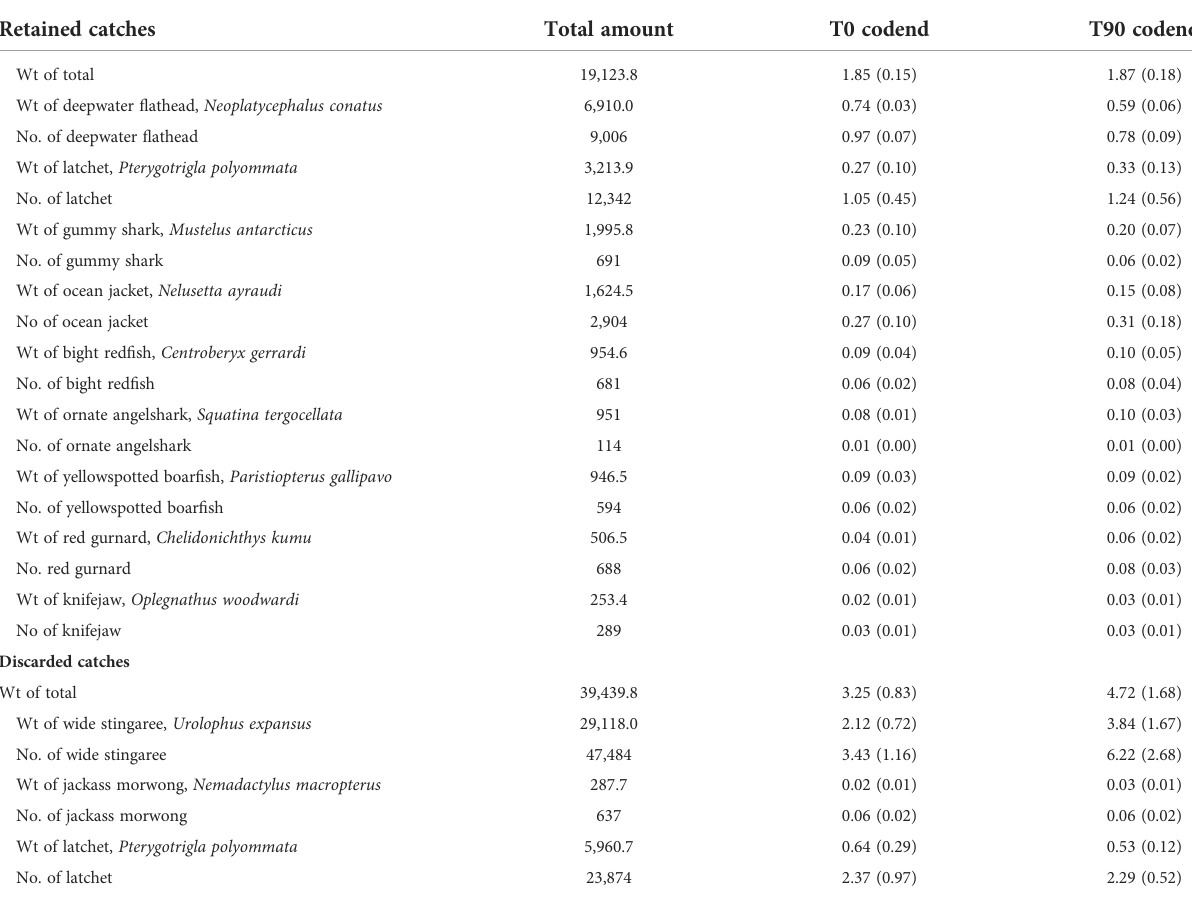
TABLE 1 Summary of catches (and their totals) tested in mixed-effect models assessing the importance of codend con fi guration and the means ± SE ha – 1 trawled separated for the T0 and T90 codends.